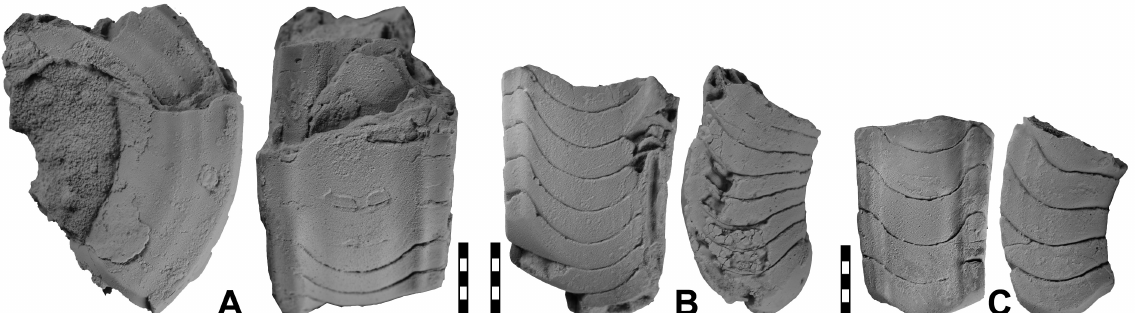
Fig. 14. Vestinautilus angulatus sp. nov. from Oued Temertasset (all Korn et al . 2002 Coll.). A . Paratype MB.C.30462.1. B . Holotype MB.C.30461.1. C . Paratype MB.C.30461.2. Scale bar units = 1